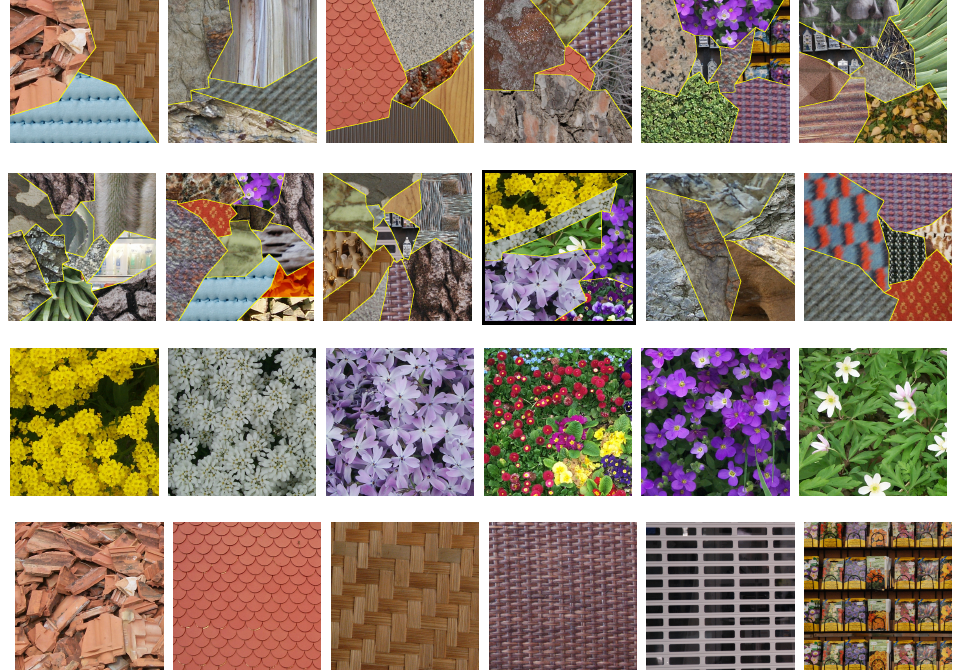
Figure 4. Examples of test images ( top two rows) and training images (from “flowers” and “man- made” categories, bottom two rows) from the Prague dataset. Note that the framed test image represents K I = 6 classes from the sole “flowers”